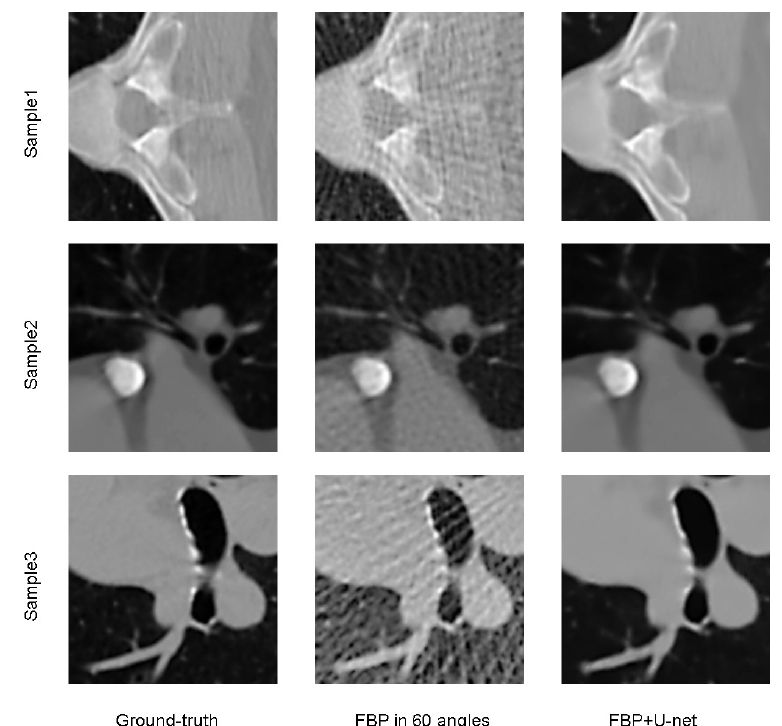
Figure 11. Comparison in region of